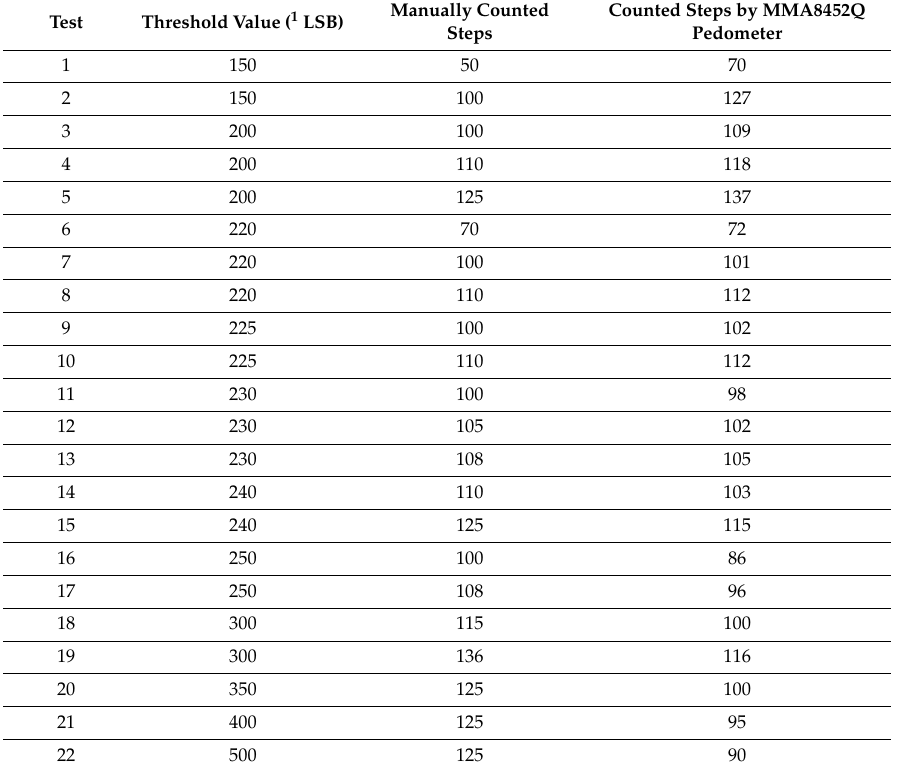
Table 6. Comparison of the number of steps calculated by the MMA8452Q accelerometer used as pedometer with the steps number counted manually by a second subject, during a walk at a normal pace.